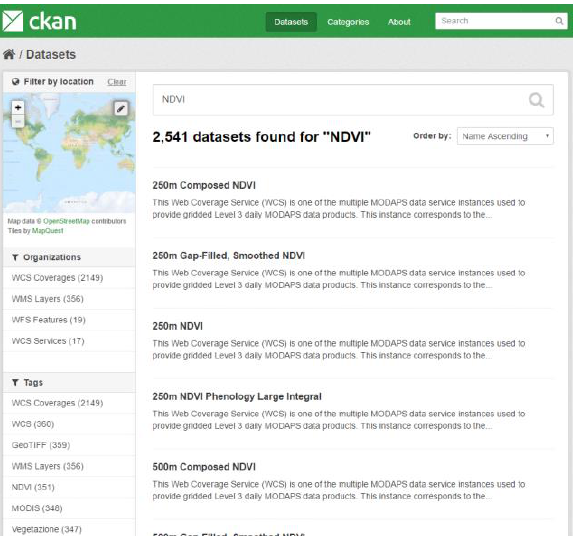
Figure 10. GUI of CKAN instance deployed as pilot data portal providing access to Bolegweb resources for Open Data